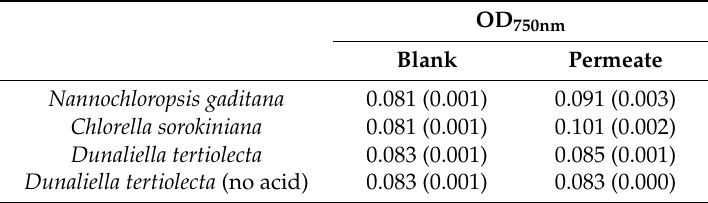
Table 3. Optical density at 750 nm after filtration of steam exploded microalgae. Raw values are compared to filtered (0.45 µ m) seawater (blank). Values are expressed as the mean and the standard deviation is provided in